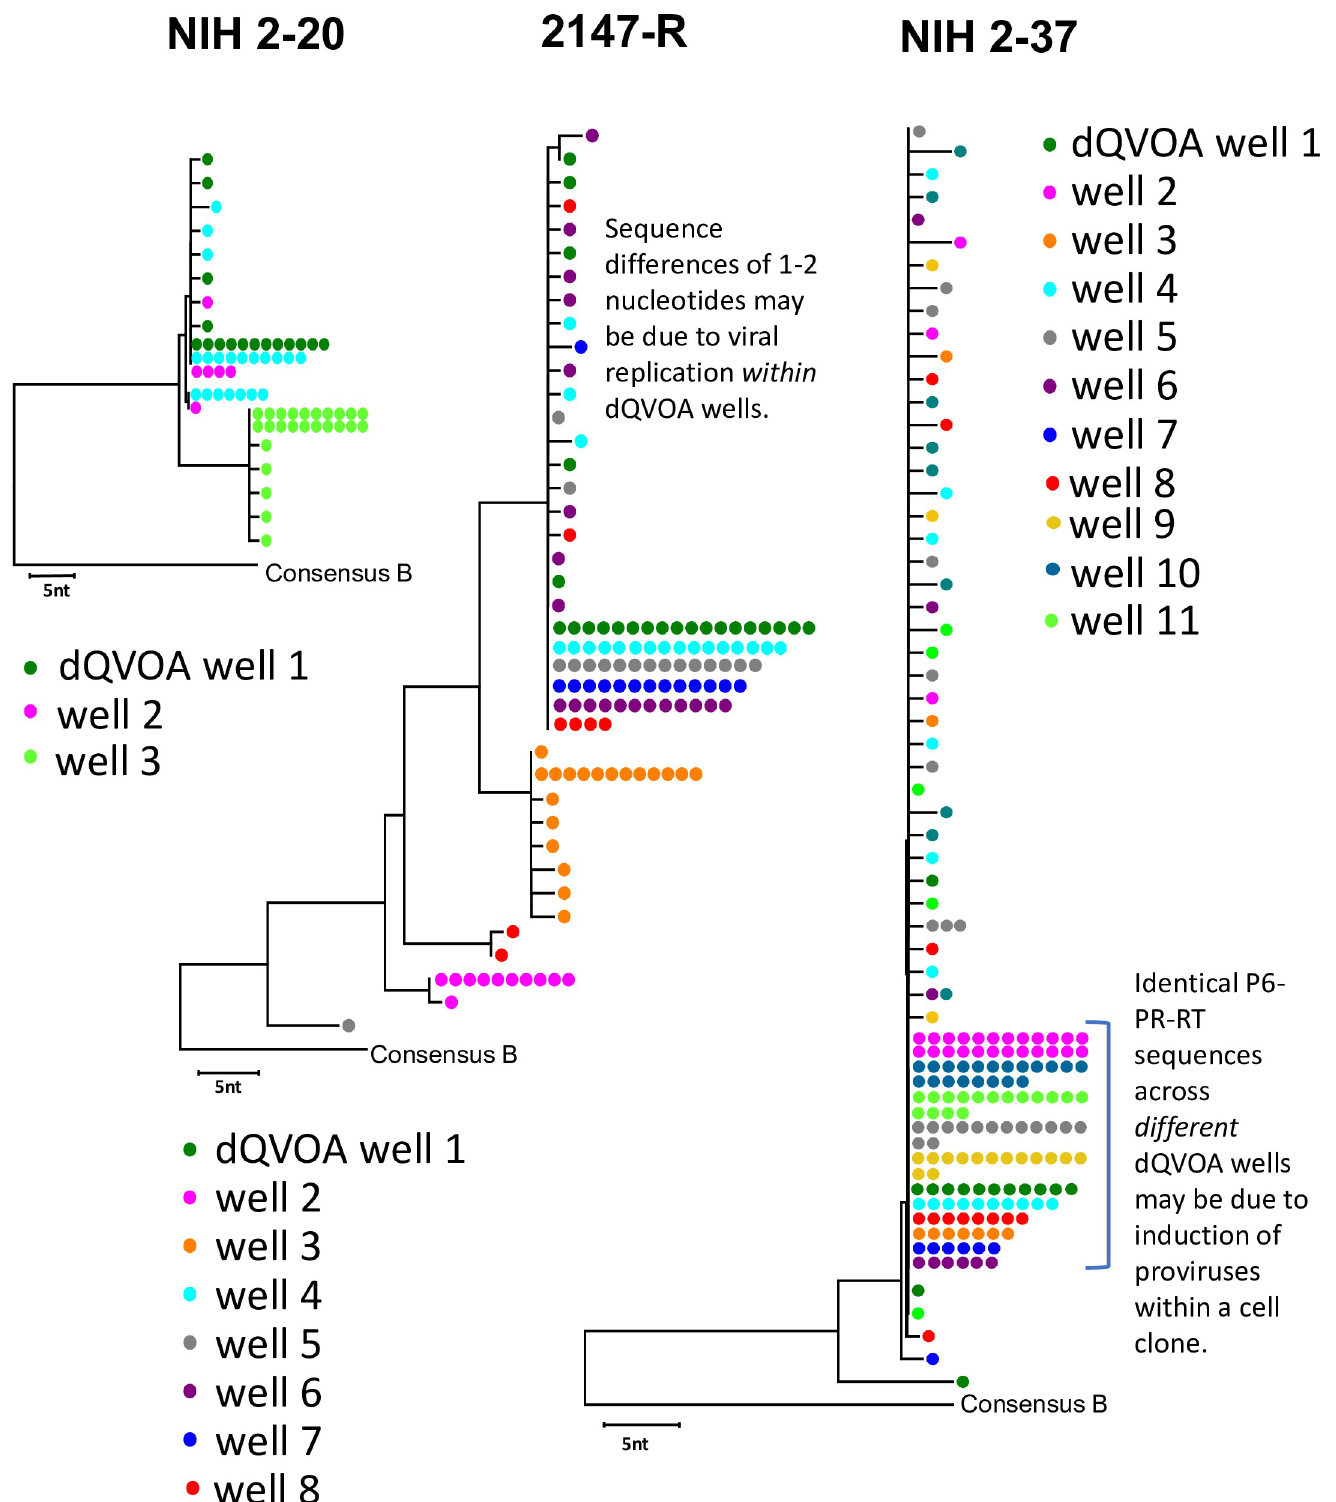
Fig 4. Differentiation drives reactivation of clonally-expanded, replication-competent HIV-1. P6-PR-RT single-genome sequencing[78] was performed on HIV- 1-Gag+ culture supernatants from dQVOA on NIH participant 2–20 (n = 2), NIH participant 2–37 (n = 1), and RAVEN participant 2147-R (n = 1). Circles represent single RNA genomes in the supernatants. Sequences obtained from different wells are shown in different colors. Identical sequences across different wells may result